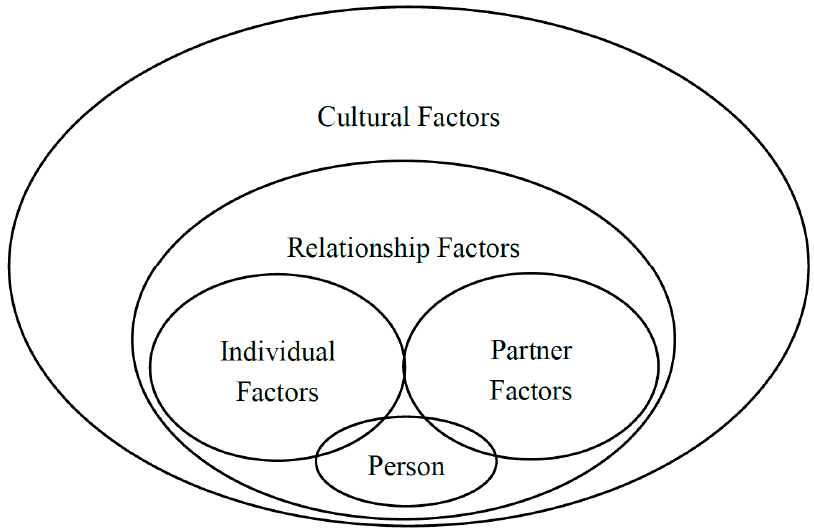
Figure 1. Levels of influence in perceptions of intimate partner aggression.